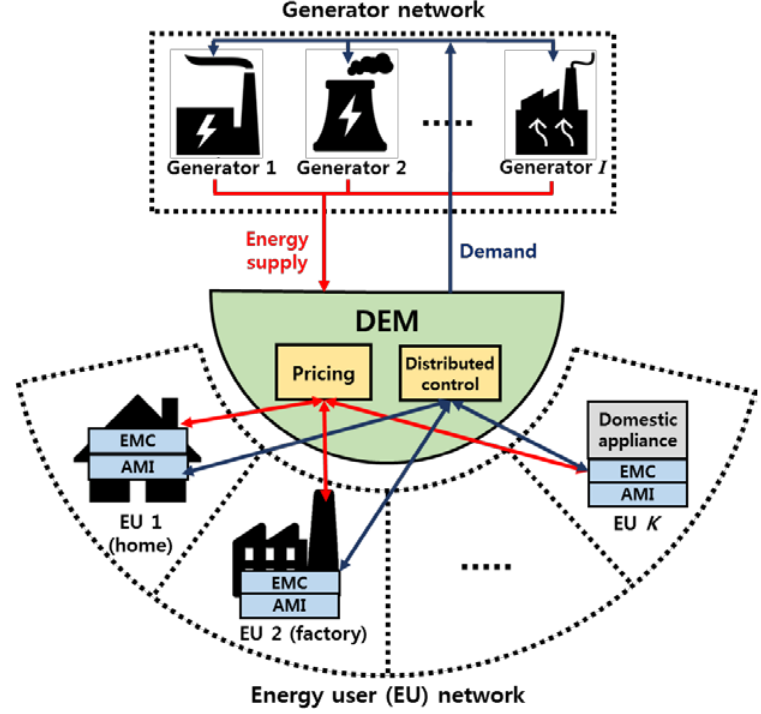
Figure 1. Systemic model of social-welfare maximization in a smart grid with demand response (DR) systems.